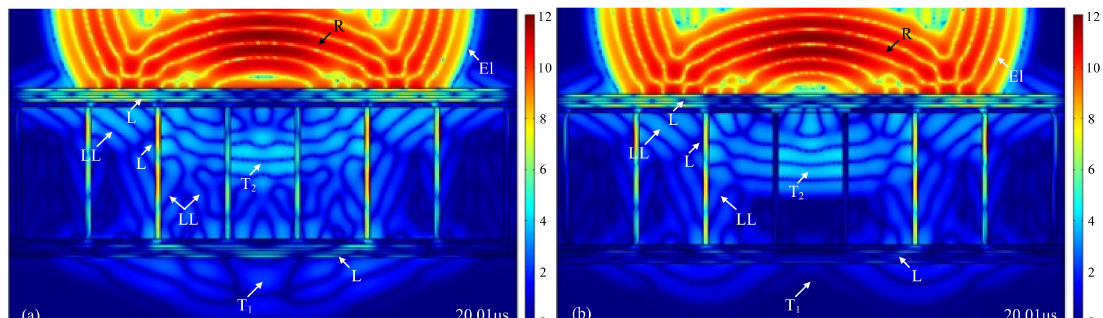
Figure 8. The sound field distribution of a intact honeycomb sandwich composite model and a honeycomb sandwich composite model with embedded debonding defect at 20.01 µ s; ( a ) The sound field distribution of an intact honeycomb sandwich composite model at 20.01 µ s; ( b ) The sound field distribution of a honeycomb sandwich composite model with an embedded debonding defect at 20.01 µ s. R: reflected longitudinal wave; El: edge longitudinal wave; T1: transmitted longitudinal wave; T2: transmitted longitudinal wave; LL: leakage Lamb wave; L: Lamb wave.